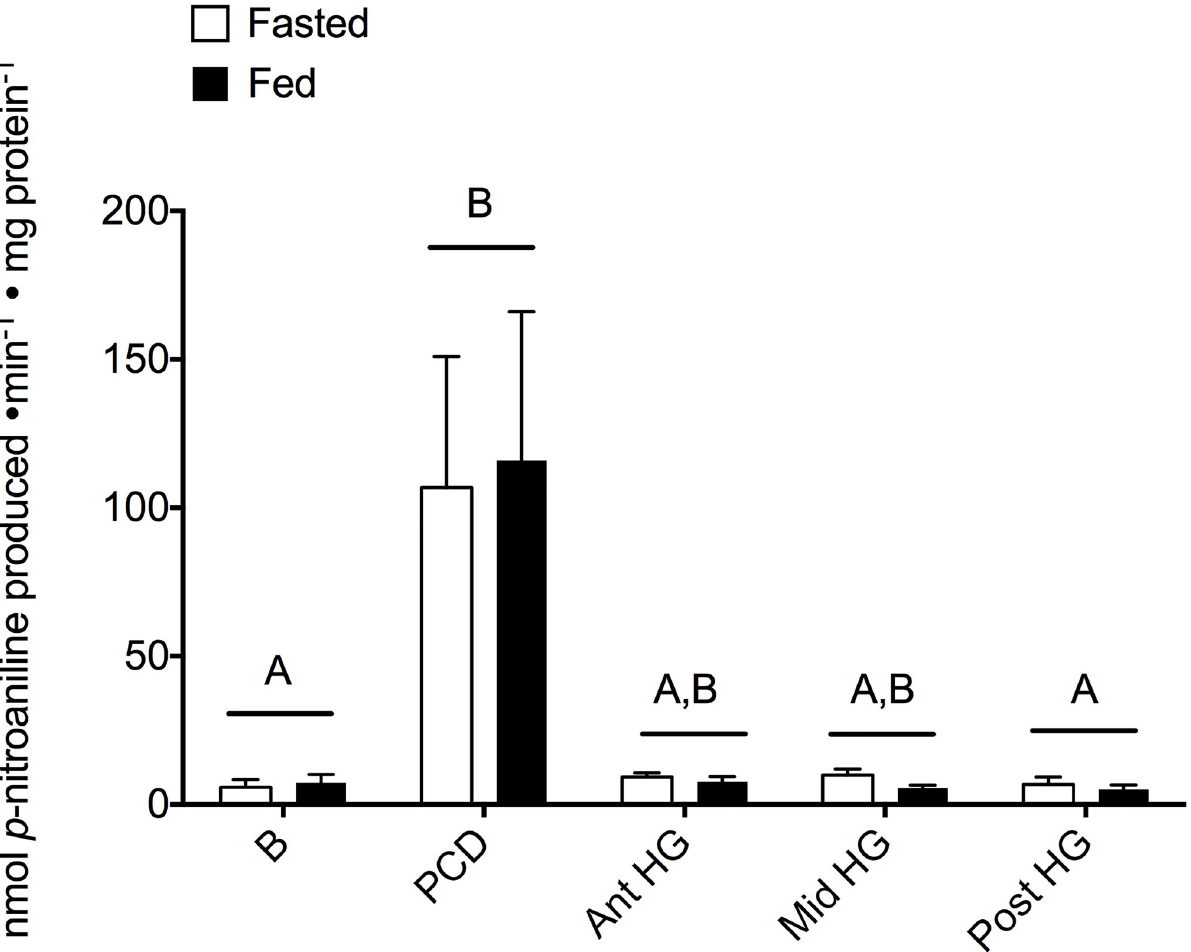
Fig 5. The activity of aminopeptidase (nmol p -nitroaniline produced min -1 mg protein -1 ) varies with location along the Pacific hagfish alimentary canal. Activity was measured in both fasted (white bars) and fed (black bars) hagfish in five locations down the alimentary canal (B—buccal cavity, PCD —pharyngocutaneous duct, Ant HG—anterior hindgut, Mid HG—mid hindgut, Post HG—posterior hindgut). Bars represent means + s.e.m. of 5–12 hagfish. A Kruskal-Wallis determined that there were significant differences in activity between different locations, with differences indicated by different letters. Significance was accepted at α =